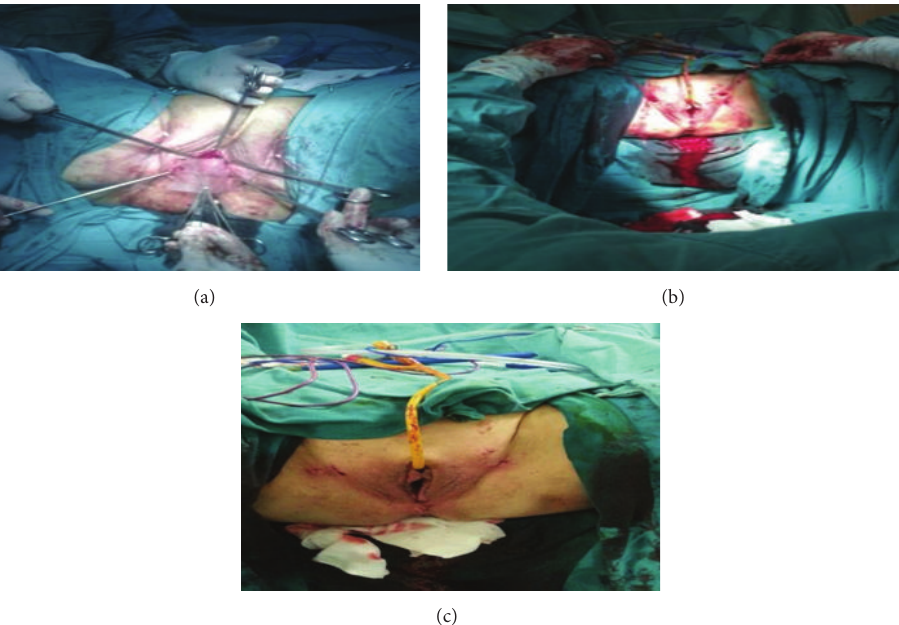
Figure 3: (a) shows that the anterior arms were placed as a midurethral sling as in the intravaginal slingplasty (IVS) procedure, supporting the midurethra and bladder. (b) shows that mesh was fixed using tension free technique. (c) shows postoperative findings of the